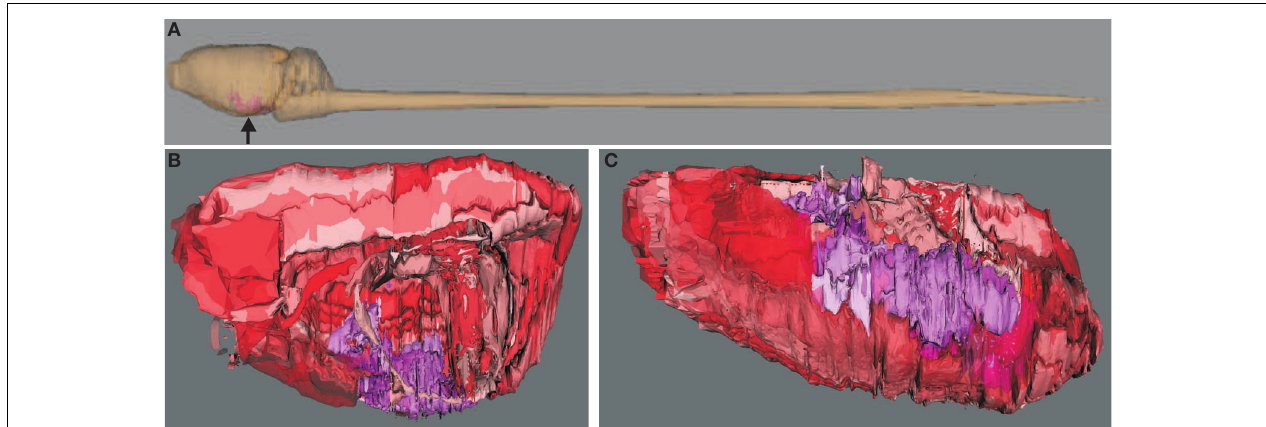
shown in (A) ].This scheme of colors is consistent with the color mapping of the complete rat nervous system connectome where further colors are already assigned to other regions (see Materials and Methods). (C) The view from ventral (bottom) shows the rostrocaudal extension of the amygdala.The rough surfaces are caused by the intersection distance, serial sectioning, and small subregions of the